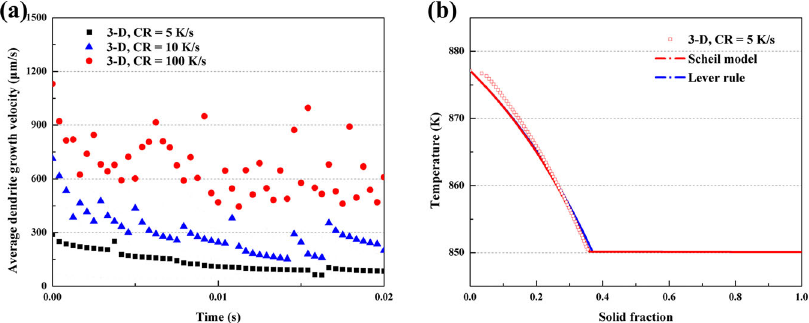
Fig. 3 Dendrite growth kinetics. a Comparison of the average dendrite growth velocity with different cooling rates, and b solid fraction vs. temperature obtained by 3-D CA simulation, Scheil model, and lever relative slow solute diffusion provides a condition close to equilibrium growth. Therefore, the solid fraction curve of 5 K s − 1 fi ts the lever rule. When the cooling rate is increased to 10 K s − 1 , a faster increase of solid fraction is observed. However, when the cooling rate is 100 K s − 1 , the solid fraction becomes lower than at dendrite growth velocity at the beginning. It should be noted that with a cooling rate of 100 K s − 1 , the temperature decreases considerably faster than in the other two conditions. At higher cooling rates, fi ner dendrites will form with more secondary dendrites than dendrites formed at slower cooling rates. Mean- while, the higher cooling rate leads to a higher solid fraction when the temperature is lower than 865 K.